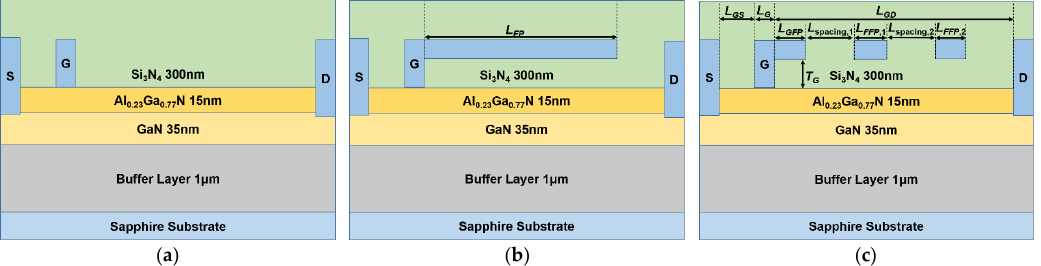
Figure 1. Cross-section of ( a ) the basic structure, ( b ) the GFP structure, and ( c ) the 2FFP structure AlGaN/GaN HEMTs.